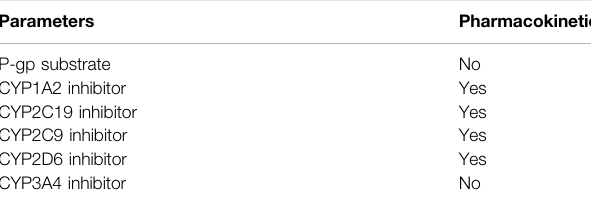
TABLE 1 | Pharmacokinetics assessment of HC-056456 as substrate or inhibitor of P-gp or CYP. Parameters